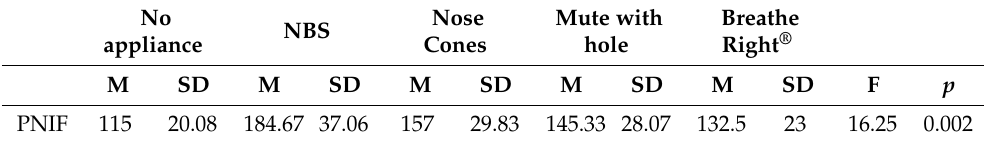
Table 2. Peak nasal inspirator flow of each